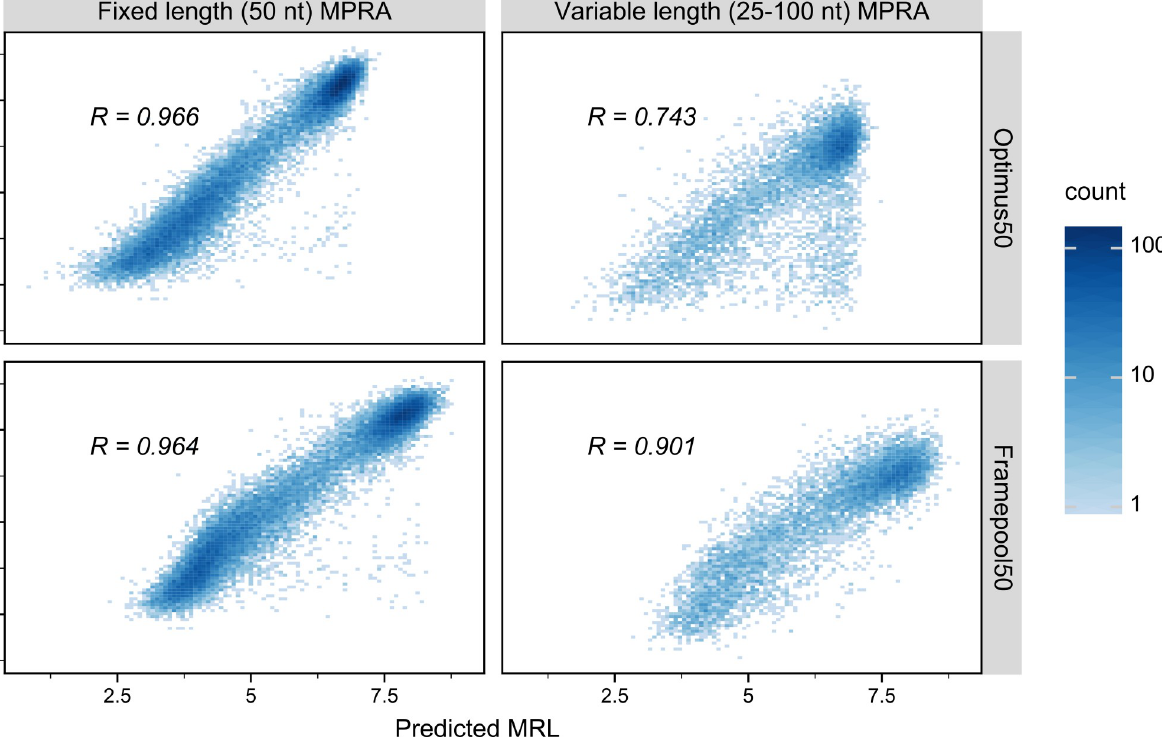
PLOS Computational Biology | https://doi.org/10.1371/journal.pcbi.1008982 May 10,